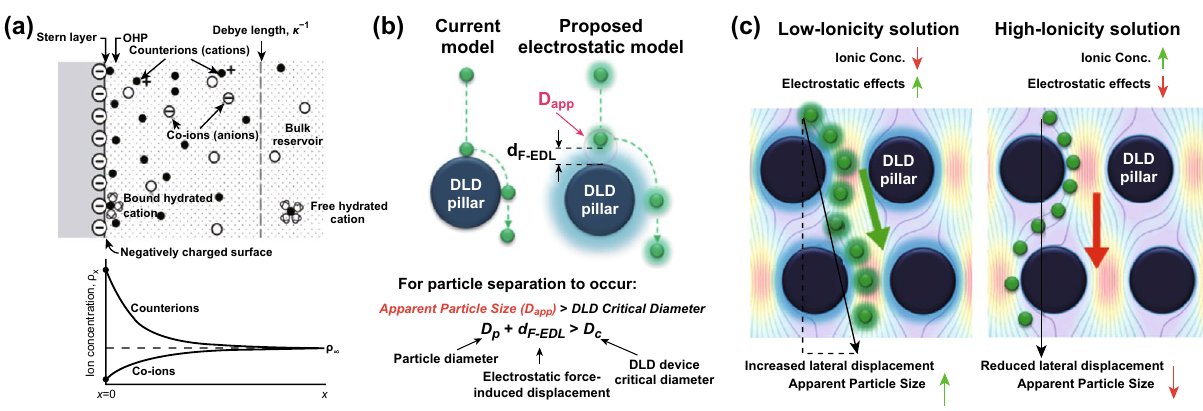
Fig. 9 a Surface electrostatic ionic interactions in a charged wall [67]. b The proposed model of electrostatic double-layer force in DLD that modulates the apparent diameter of the particle [66]. c The electrostatic force enhances the particle lateral displacement at low ionic buffer strength, while the electrostatic charge is shielded at a high ionic concentration buffer [66]. Figure panels reproduced from Ref. [67] with per- mission from Elsevier, copyright 2011, Ref. [66] with permission from the Royal Society of Chemistry, copyright